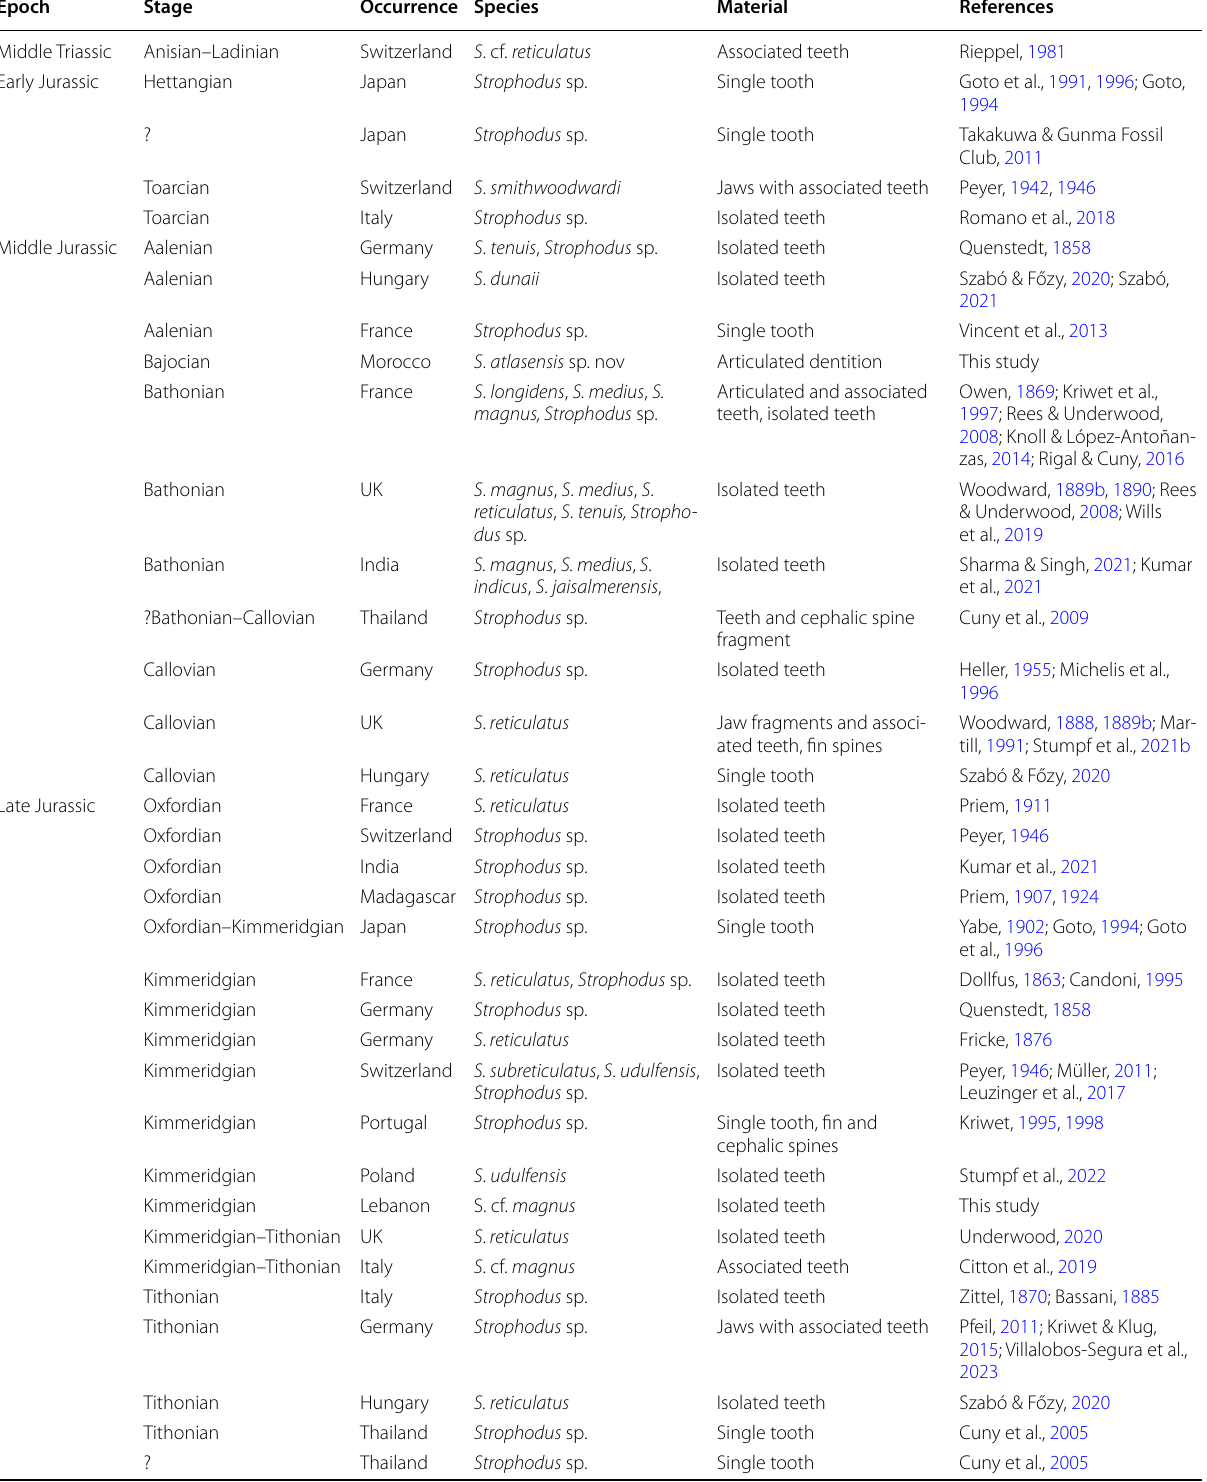
Table 1 The fossil record of